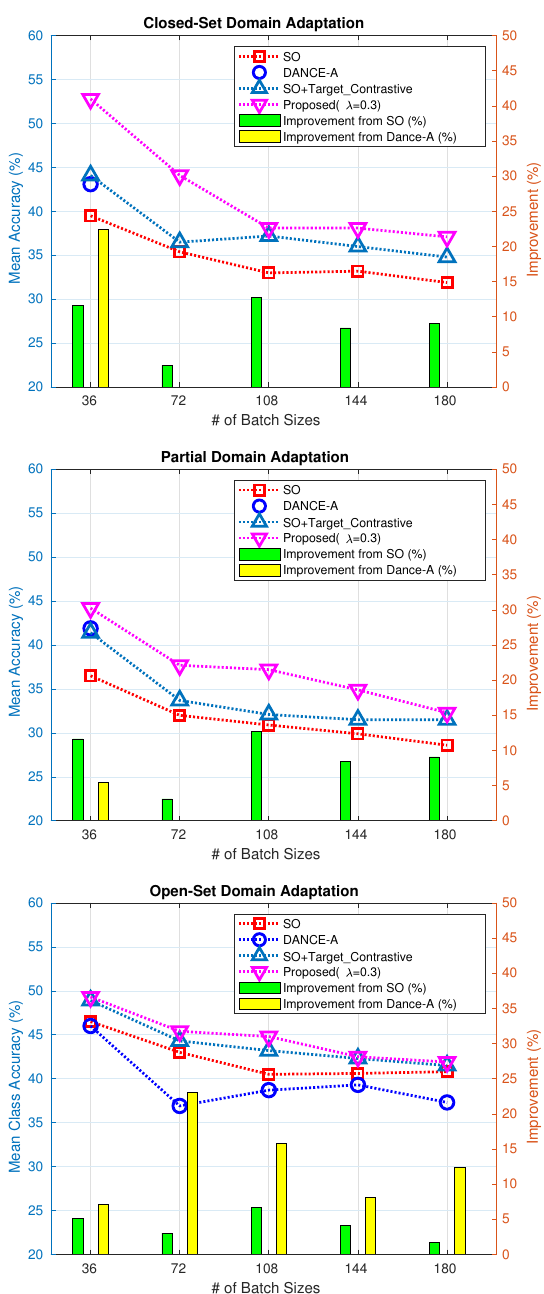
Figure 5. The effect of batch sizes on MNIST to SVHN datasets. ‘SO’, ‘DANCE-A’, and Proposed ( λ = 0.3) are the same those in Table 3. ‘SO+Target_Contrastive’ means is the addition of target contrastive learning loss to ’SO’. The accuracy improvement rates are represented by green and yellow bars. In the case of optimization unstable, it remains blank.